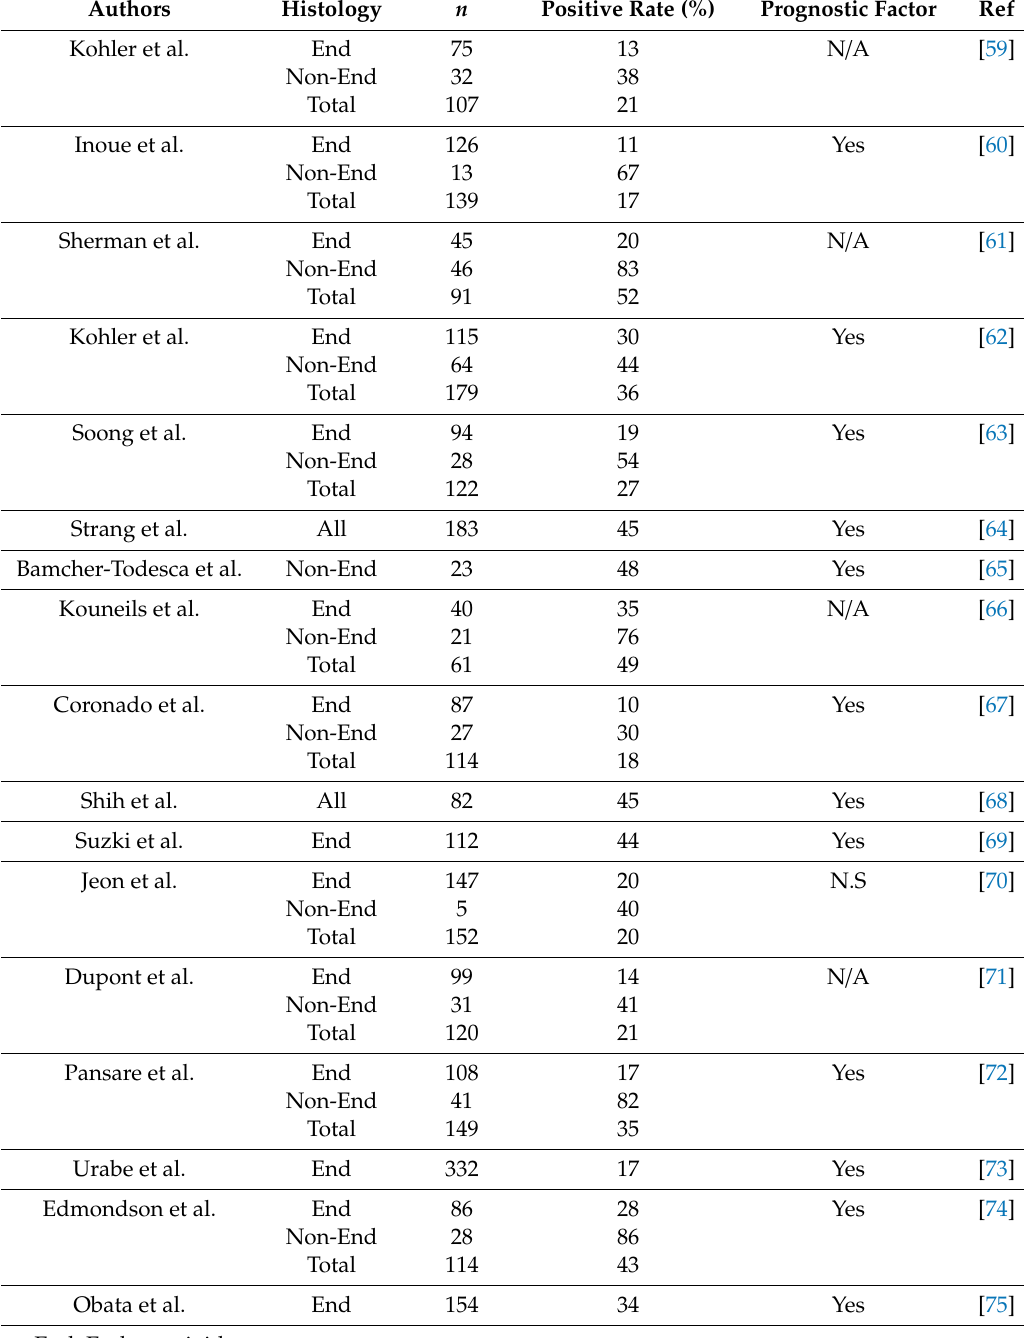
Table 1. The rate of p53 immunoexpression and prognostic impact in endometrial cancer